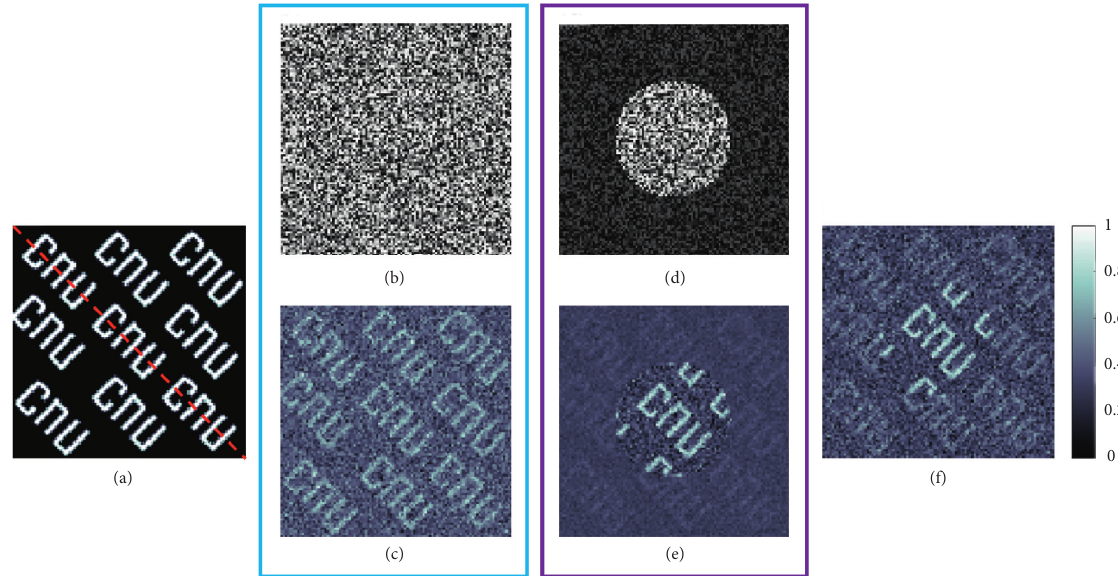
Figure 5: Simulation results of the “cnu” image. (a) Original image. (b) Speckle pattern with uniform light intensity distribution. (c) Simulation result based on (b) (10,000 measurements). (d) Speckle pattern with uneven light intensity distribution ( r � 3). (e) Simulation result based on (d) (10,000 measurements). (f) Simulation result obtained by the proposed method, that is, the uneven light field is only loaded in the object